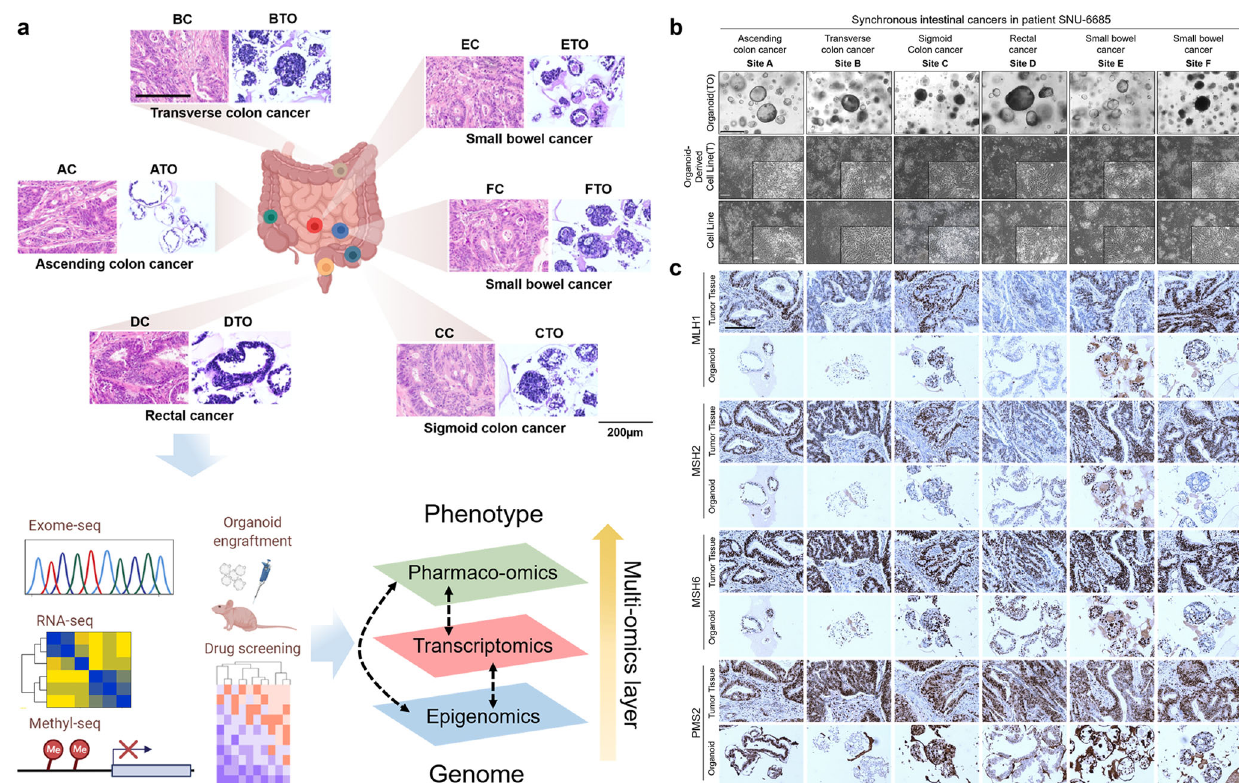
Fig. 1 Histopathological characterization of SIC patient-derived organoids and cell lines. See also Supplementary Fig. 1 and Table 1 . a Overall study design. The cartoons representing gut, exome-seq, RNA-seq, methyl-seq, organoid engraftment, drug screening, and arrows were illustrated by BioRender. The H&E slides of multifocal tumor tissues and organoids as well as the images representing multi-omics layers were original pictures created by the authors. We successfully generated 6 PDOs and 12 PDCs (6 PDCs and 6 PDO culture-derived PDC cultures) corresponding to one synchronous intestinal cancer (SIC) patient. We compared multi-omics data from all sub-regional derivatives and analyzed heterogeneous factors that might affect drug responses, Scale bar = 200 μ m. b The morphology of SIC organoids and cell lines derived from the patient SNU-6685. All PDOs had mixed morphology and retained both the inter-tumor and intra-patient heterogeneity. Established cell lines were composed of relatively uniformed clones compared to organoids, cellular structures were comprised of mono- layered epithelial cells displaying polygonal morphology and cell aggregates were formed in all of PDCs and PDOCs. Scale bar = 500 μ m and insets are ×200. c Organoids resemble primary tumor epithelium in histological features. The protein expressions of MMR genes include MutL Homolog 1 ( MLH1 ), MutS homolog 2 ( MSH2 ), MutS Homolog 6 ( MSH6 ), and PMS1 Homolog 2 ( PMS2 ) in PDOs resembled their corresponding tumors, Scale bar = 200 μ